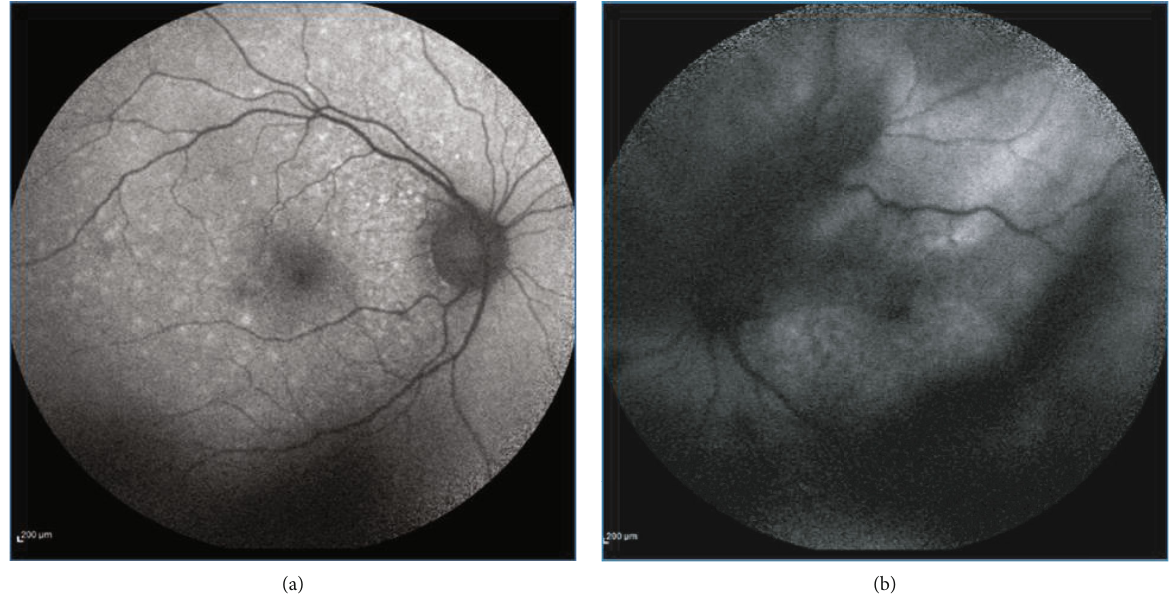
Figure 3: Fundus auto fl uorescence (FAF), one month after starting the antiviral therapy. (a) Right eye: numerous hyperauto fl uorescent dots scattered on the posterior pole without vitreous opacity. (b) Left eye: stippled mixed hyper-hypoauto fl uorescent dots (leopard pattern) at the posterior pole and hypoauto fl uorescent vitreous opacity corresponding to the